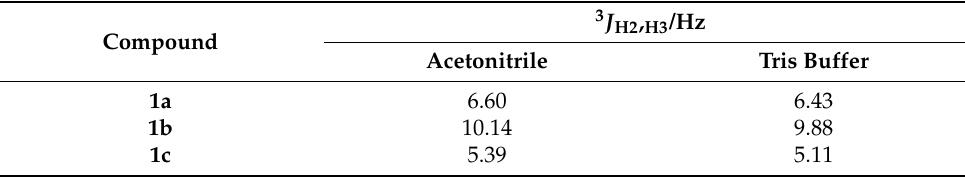
Table 2. Vicinal coupling constants 3 J H2 , H3 for 1a – c in free state.